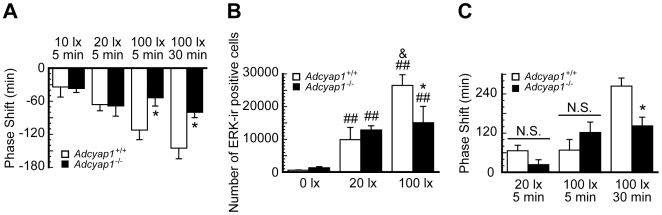
Impaired light-induced behavioral phase shift in Adcyap1
−/− mice.(A) Quantification of light-induced phase delay at CT15 (n = 5–7 for 5 min, n = 4–5 for 30 min). (B) Numbers of phosphorylated ERK-immunoreactive (pERK-Ir.) cells in the SCN (n = 4–7). (C) Quantification of light-induced phase advance at CT21 (n = 4–5). Values denote means ± SEM. *
p<0.05 versus Adcyap1
+/+ mice at 100lx, ##
p<0.01 versus each genotype at 0lx, &
p<0.05 versus Adcyap1
+/+ mice at 20lx; Mann-Whitney U test followed by Kruskal-Wallis Test.